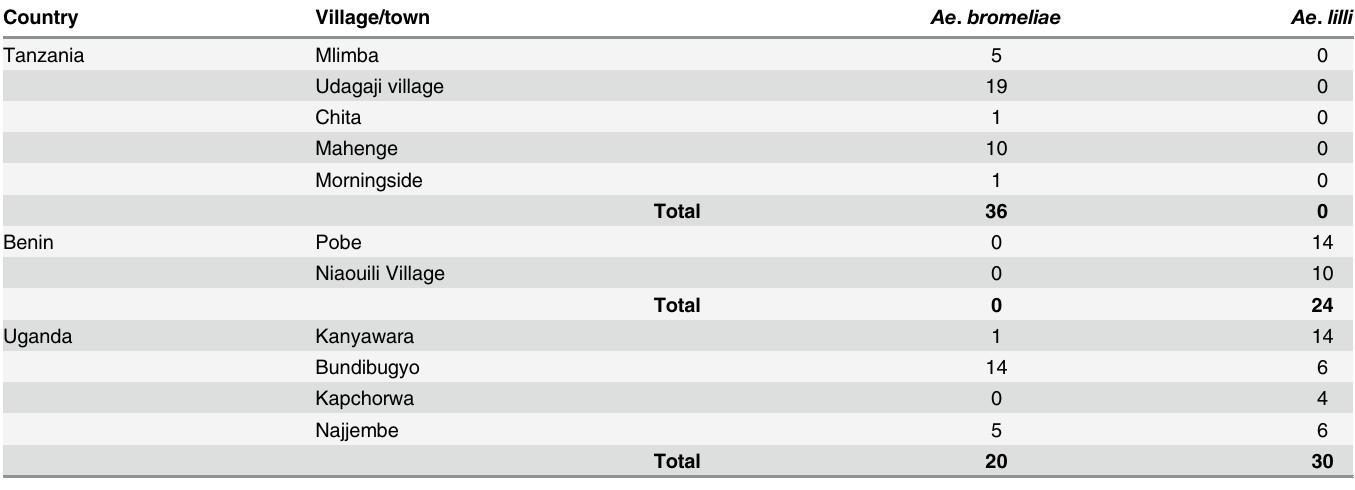
Table 1. The number of individuals (n = 110) identified from sampled locations using our PCR mediated identification method. Country